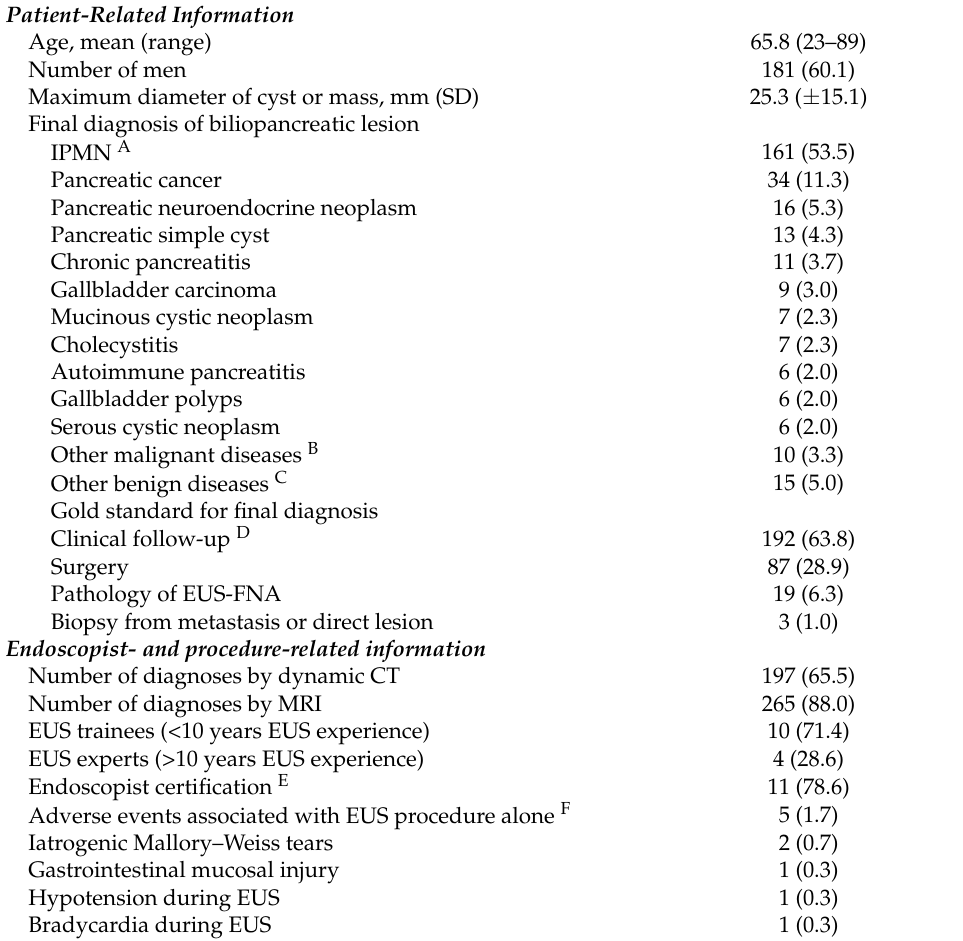
Table 1. Characteristics of patients who underwent CH-EUS of biliopancreatic lesions (n = 301). Patient-Related